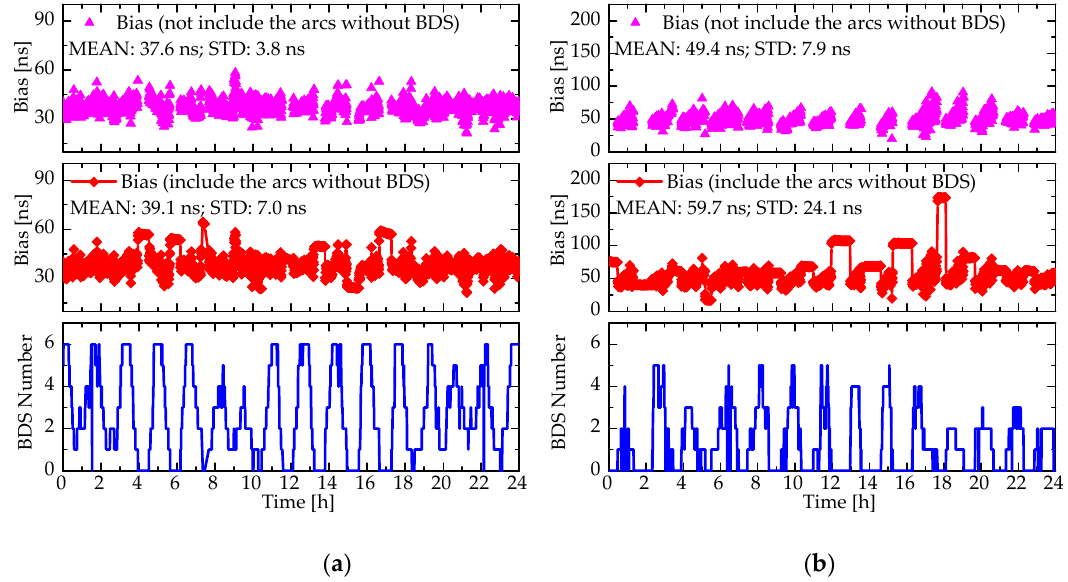
Figure 10. Estimation of the system bias between GPS and BDS: ( a ) the estimated bias sequences and the corresponding number of tracked BDS satellites for the FY3C satellite with the pseudo-range-based solution on day 2015/70; ( b ) the estimated bias sequences and the number of BDS for the YG30/SAT1 satellite with the pseudo-range-based solution on day 2017/341.